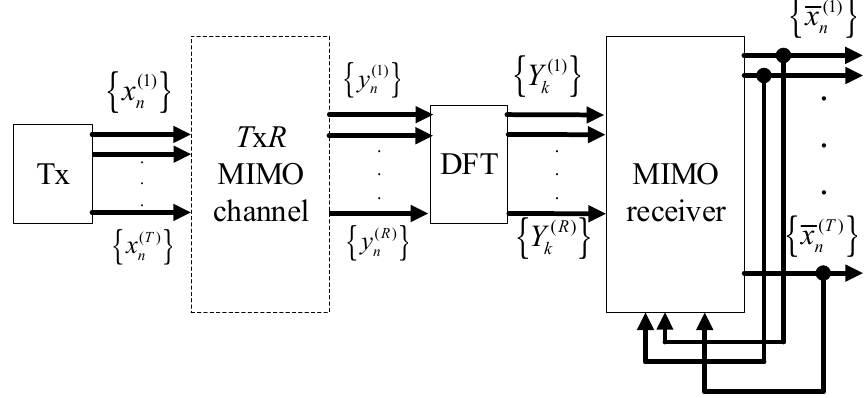
Figure 1. Block diagram of an m-MIMO system associated with SC-FDE signals.